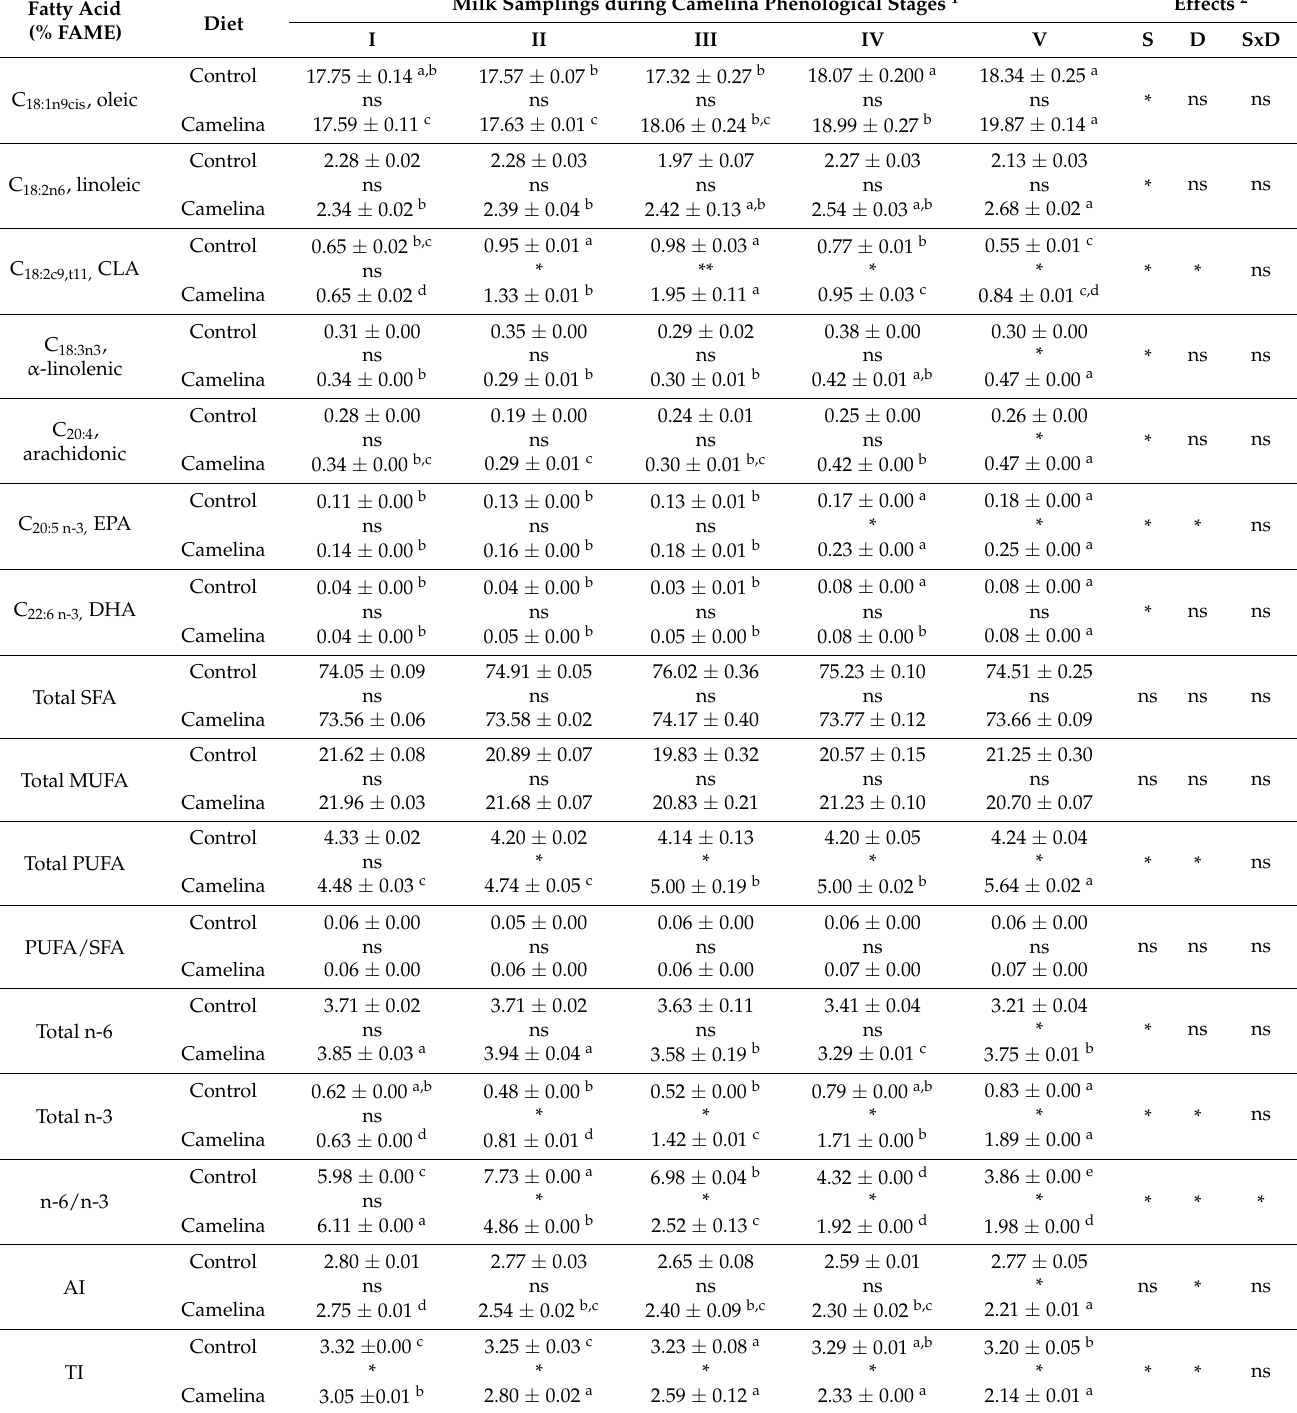
Table 7. Main fatty acid composition (% of Fatty Acid Methyl Esters, FAME) of goat milk collected during different phenological stages of Camelina (mean ± standard